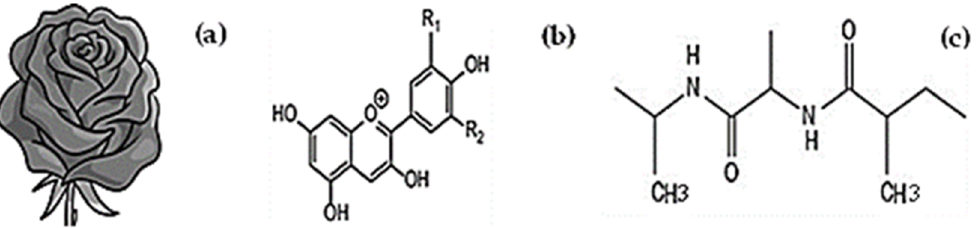
Figure 1. Structural representation of Rosa Indica flower ( a ), anthocyanin, ( b ) and a functional unit of wool fabric ( c ).